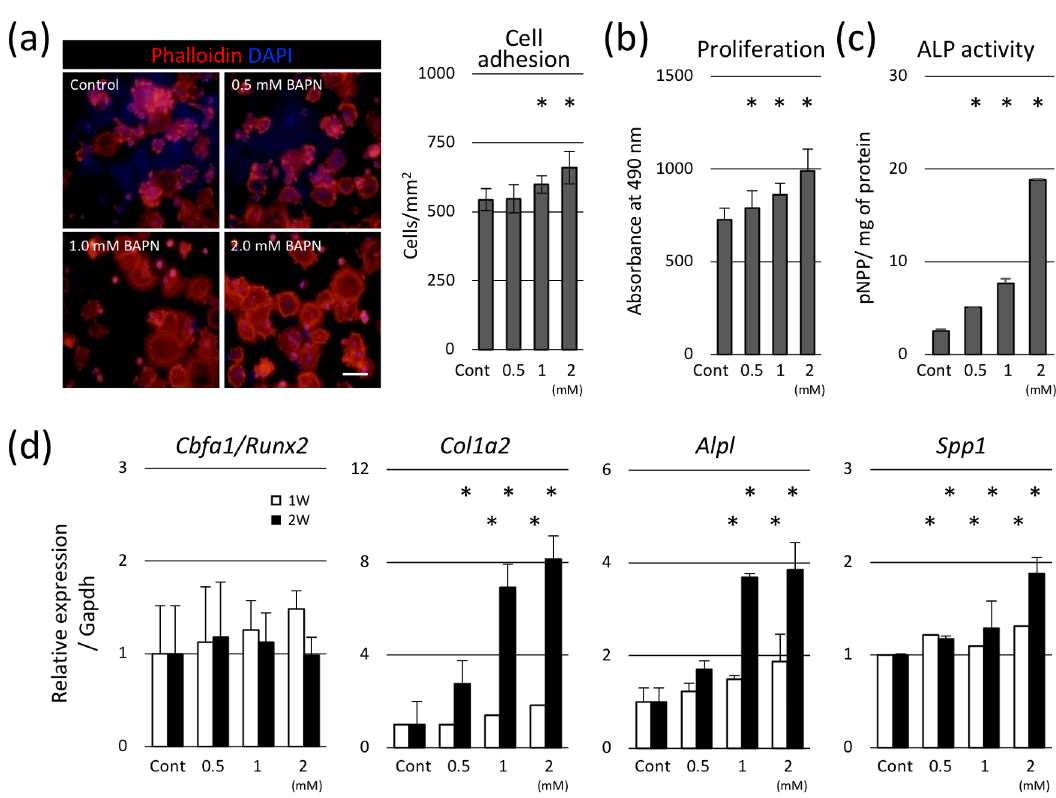
Fig 3. Effect of low cross-linked matrices on osteoblastic differentiation of BMSCs. (a) BMSCs to the prepared matrices was shown. Cell nuclei were stained using DAPI (blue), and the cytoskeleton was stained with phalloidin (red). Initial adhesion of cells cultured on low cross-link density matrix increased. (b) Proliferation of BMSCs was significantly elevated in low cross-linked matrices. (c) ALP activity of BMSCs increased in low cross-link density matrices. (d) Gene expression of Col1a2 , Alpl , and Spp1 was significantly increased, while that of Cbfa1/Runx2 did not change in low cross-link density matrices after 1 and 2 weeks. (cid:3) p < 0.05, compared to the control. Bars: 20 μ